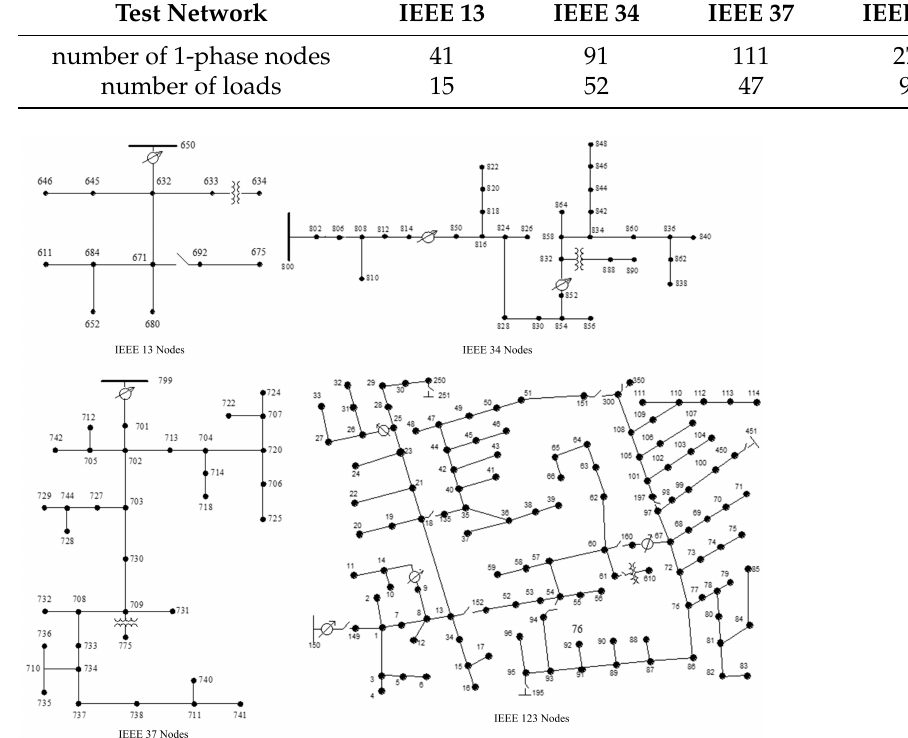
Figure 4. Configuration of test distribution feeders according to Distribution Test Feeder Working Group - IEEE PES Distribution System Analysis Subcommittee [23].